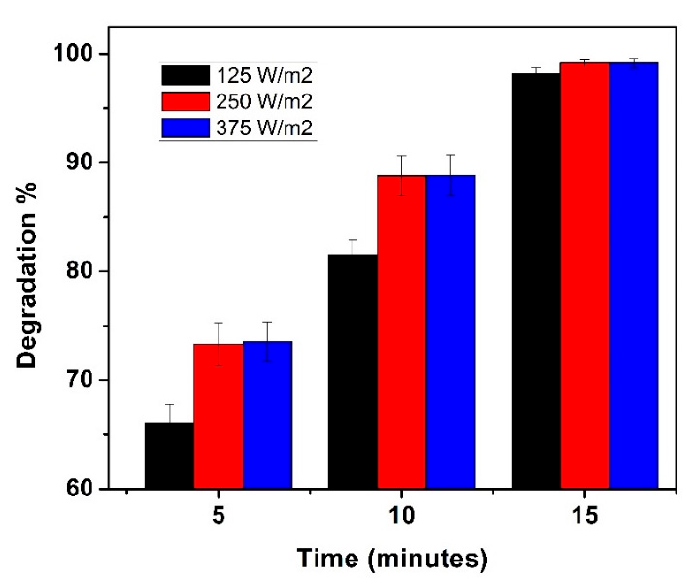
Figure 4. Comparison of pesticide degradation at different UV intensities by using combined photocatalytic ozonation process.